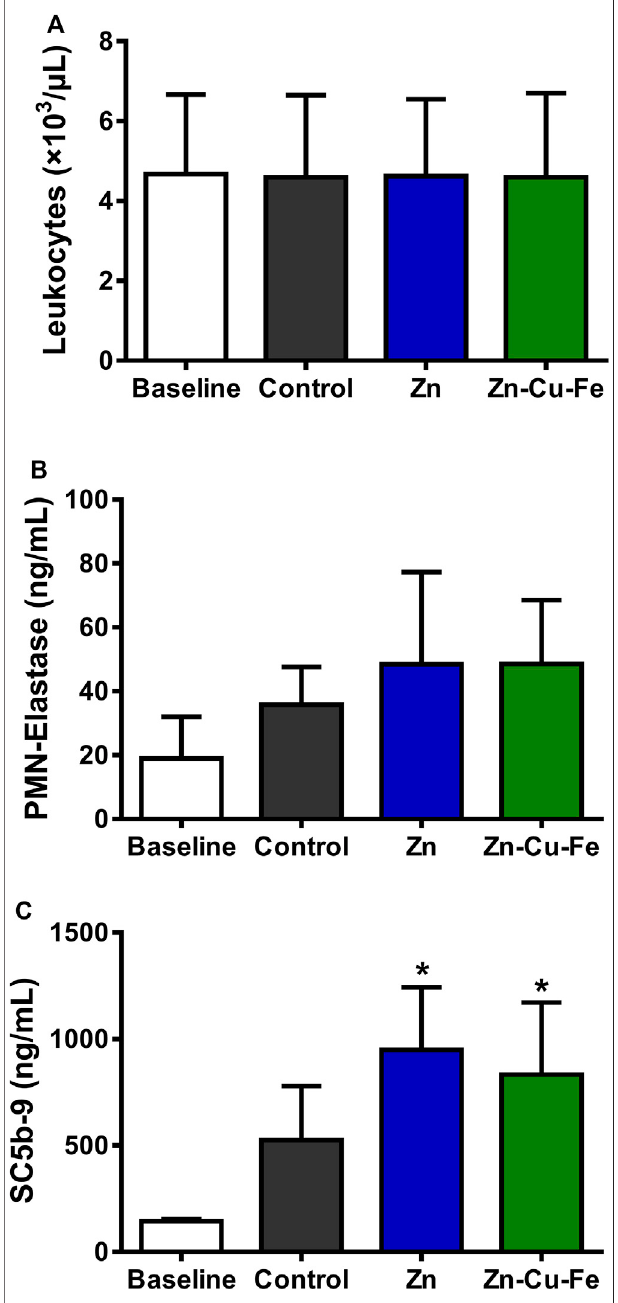
FIGURE 9 | The number of leukocytes and plasma markers after 60 min of exposure to blood using the Chandler-Loop model: (A) the number of leukocytes (10 3 / μ L), (B) the amount of PMN-elastase (ng/ml), and (C) the complement factor SC5b-9 (ng/ml). * indicates p < 0.05 according to one-way ANOVA followed by post hoc Tukey ’ s test, compared to the platelet activation ( Figure 8B ). ANOVA was used to con fi rm statistically signi fi cant differences in β -TG concentration (F (3, 12) = 9.288, p = 0.002). Post hoc pairwise comparisons indicated that the β -TG value of the control (350.9 ± 67.87 IU/ml) was